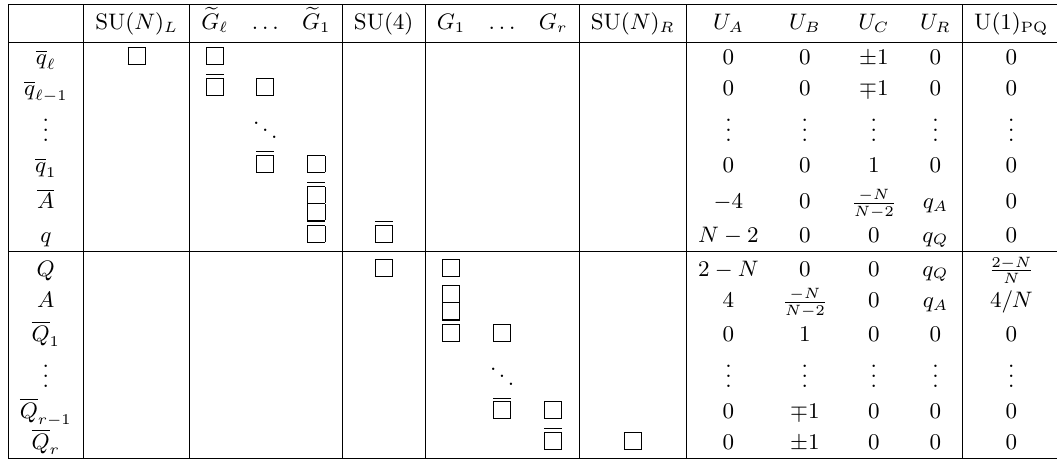
SU(4) SU( N ) r symme- (cid:2) (cid:2)